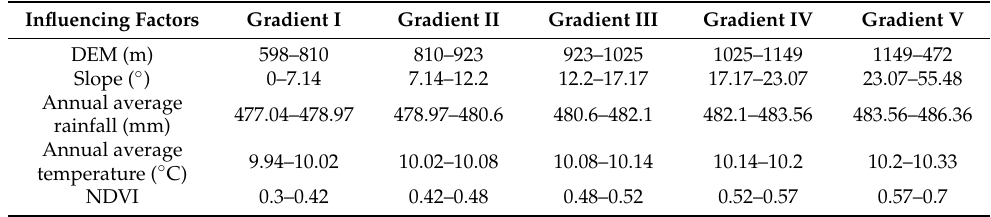
Table 8. Influencing factors classification of habitat quality.